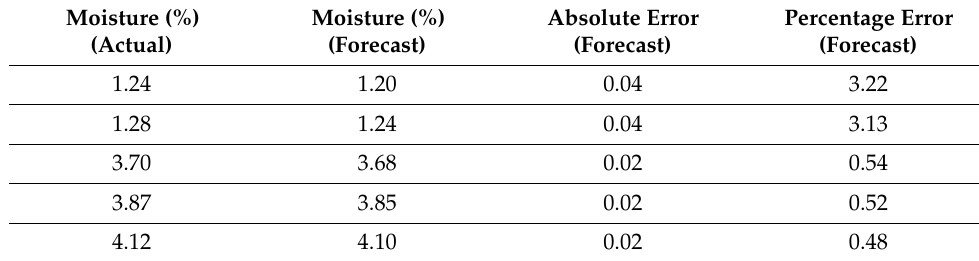
Table 3. Comparison of actual moisture, moisture forecast, and percentage